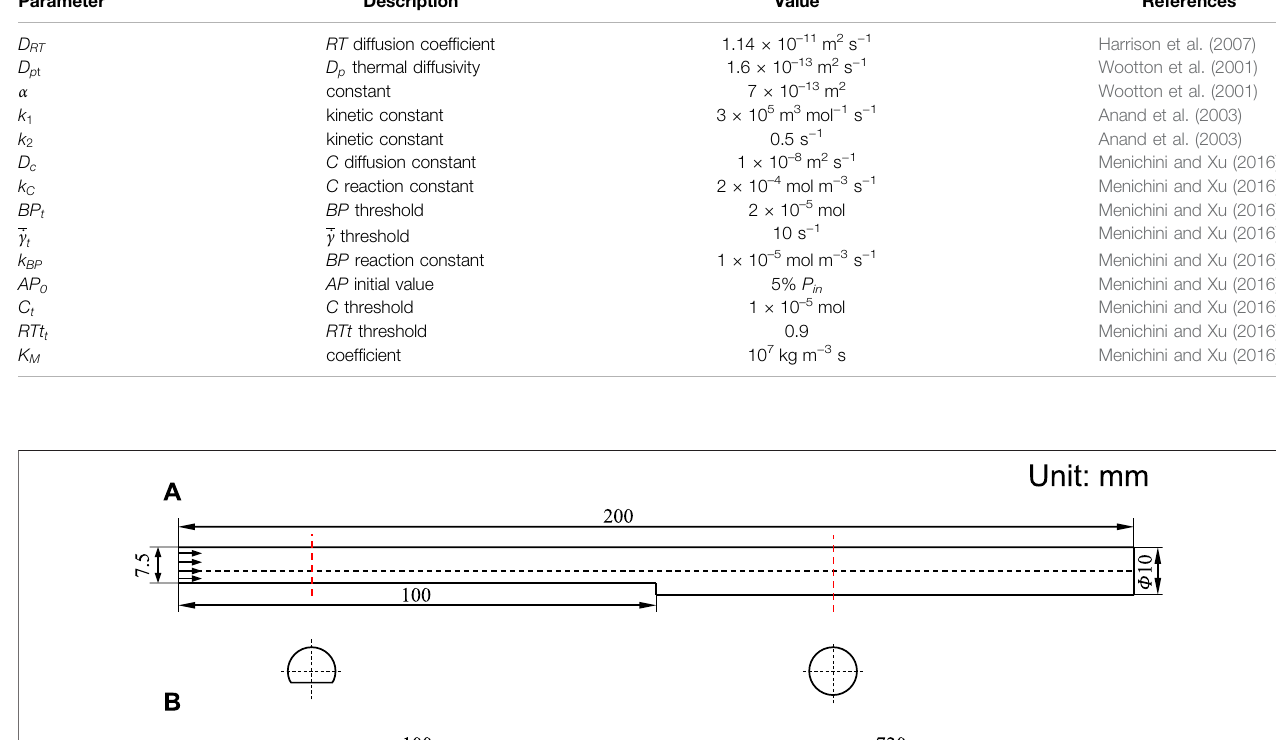
TABLE 1 | Parameters of the thrombosis computational model. Parameter